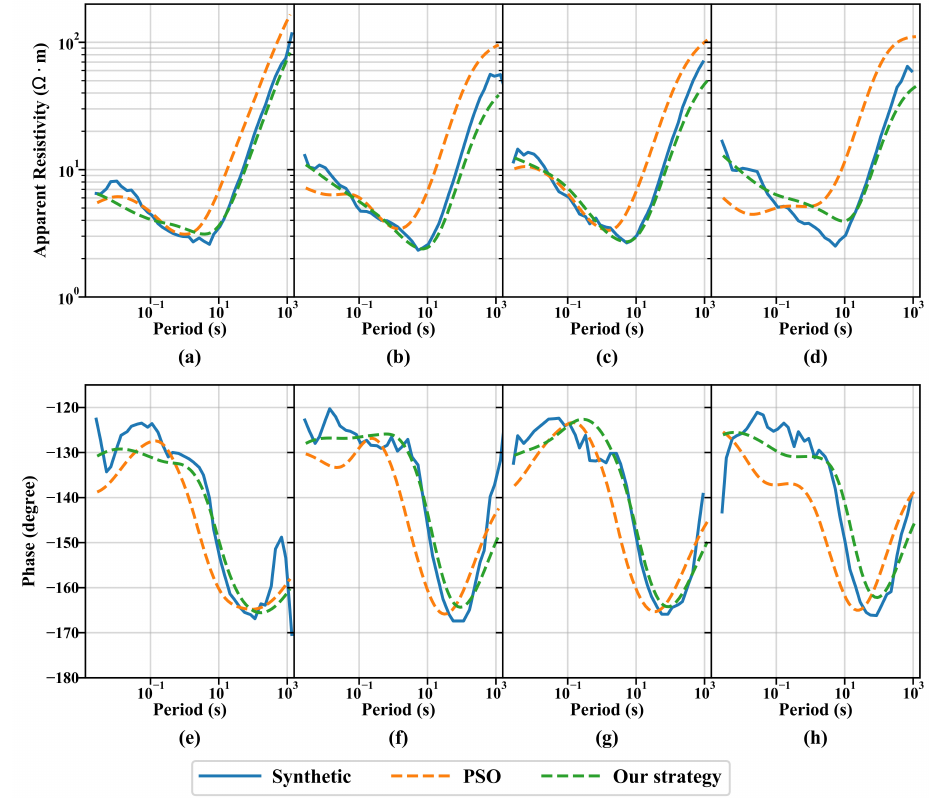
Figure 13. Comparison of the predicted and measured responses in YX mode. ( a – d ) represent the apparent resistivity response curves, and ( e – h ) represent the phase response curves. ( a , e ) represent the response curves of the fifth observation station, ( b , f ) represent the response curves of the tenth observation station, ( c , g ) represent the response curves of the 15th observation station, and ( d , h ) represent the response curves of the 20th observation station. The blue lines represent the measured response curves. The yellow lines represent the response curves predicted by traditional PSO. The yellow lines represent the response curves predicted by the proposed memetic